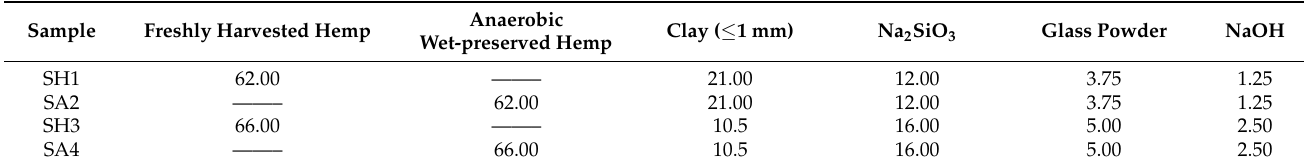
Table 3. Composition and dosage of the samples of geopolymer hempcrete (%